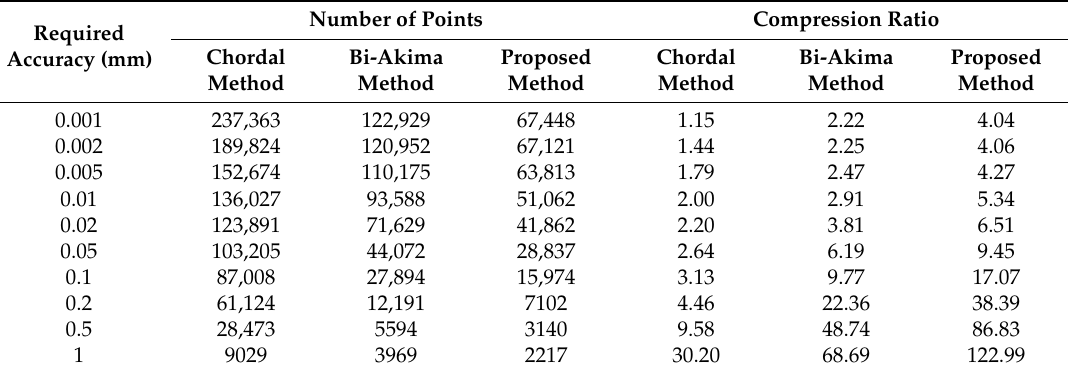
Table 2. Compression performance under different required accuracies.